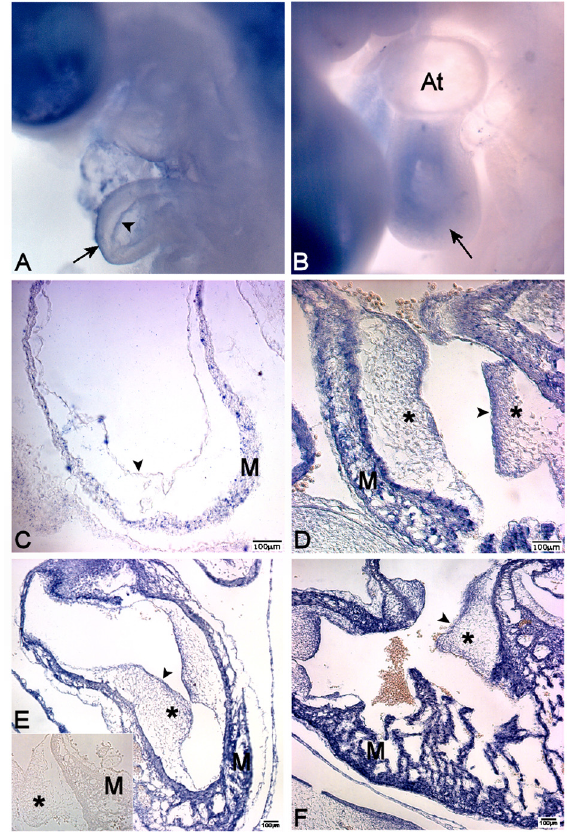
Figure 6. Localization of β2 integrin mRNA in chicken embryos using in situ hybridization. Positive labeling of β2 integrin mRNA was detected in whole mounts (A,B) and sections (C-F) of em- bryonic chicken hearts using an antisense riboprobe. A,C , HH14; B,D , HH20; E , HH25, and F , HH28. E (inset), Control in which HH25 showed no labeling with a sense probe for β2 integrin. At = atrium; M = myocardium; * = mesenchymal cells; arrows = heart; arrowheads = endothelium. Magnification bars = 100